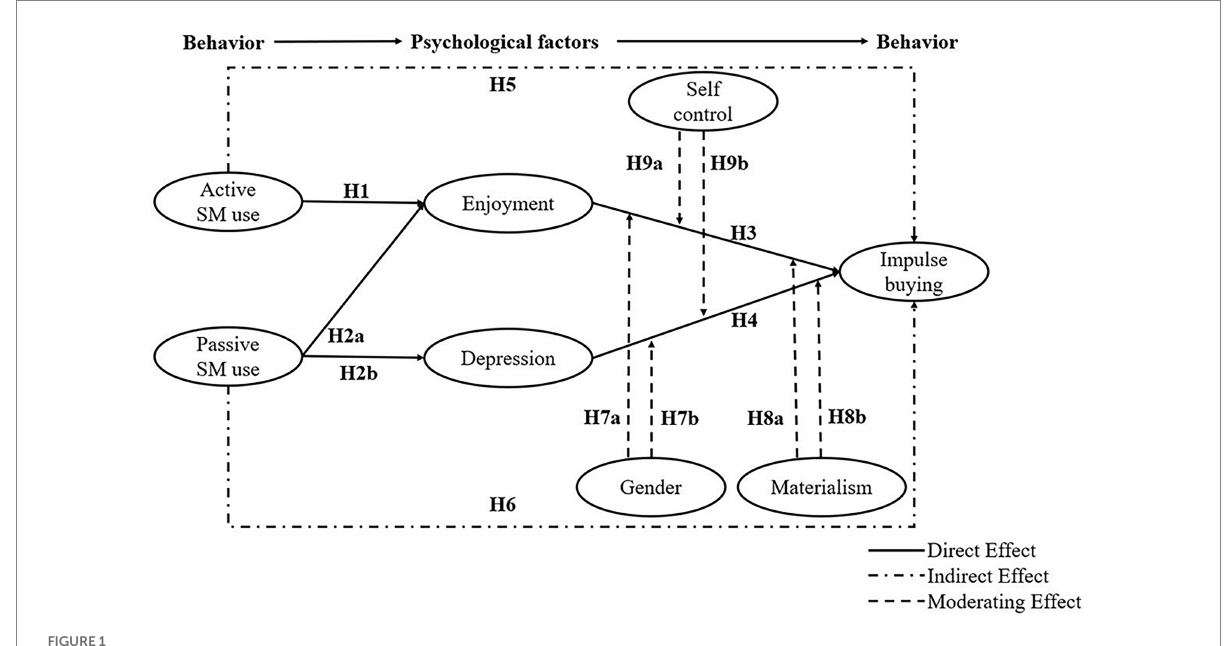
FIGURE 1 Theoretical